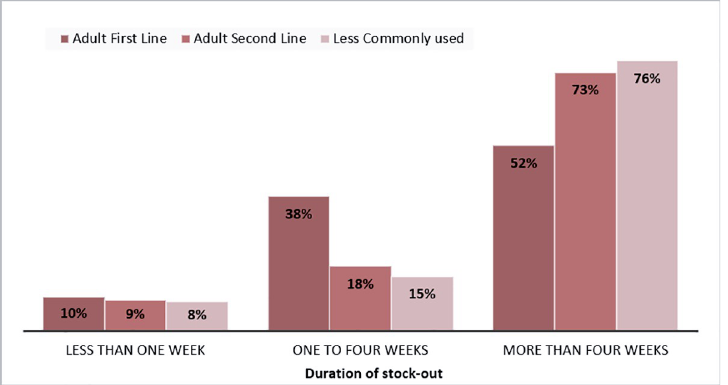
Fig 5. Percentage of resolved stock-outs lasting (i) less than 1 week, (ii)1-4 weeks, and (iii) more than 1 month by type of ARV.